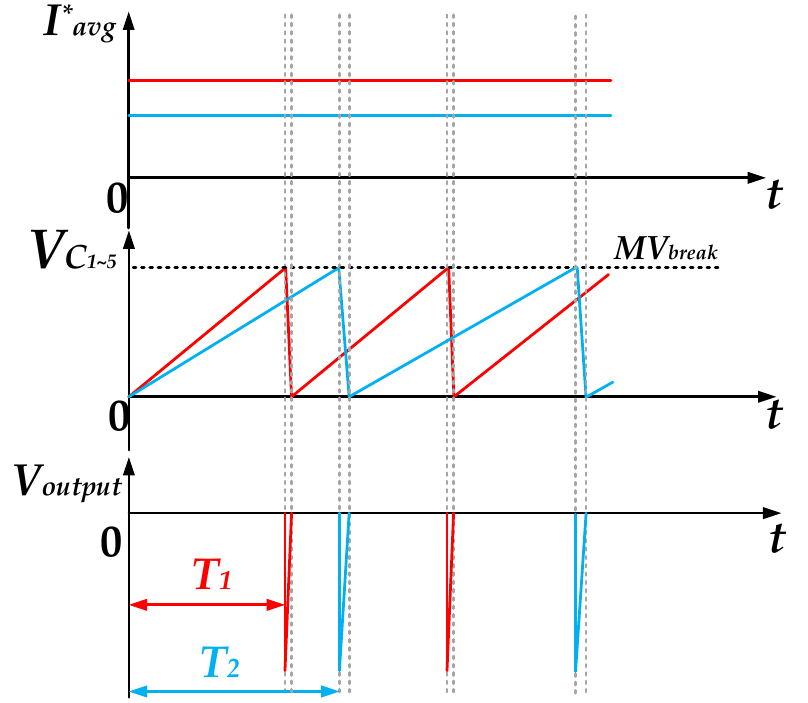
Figure 4. The theoretical waveforms with different average currents in the novel generator.